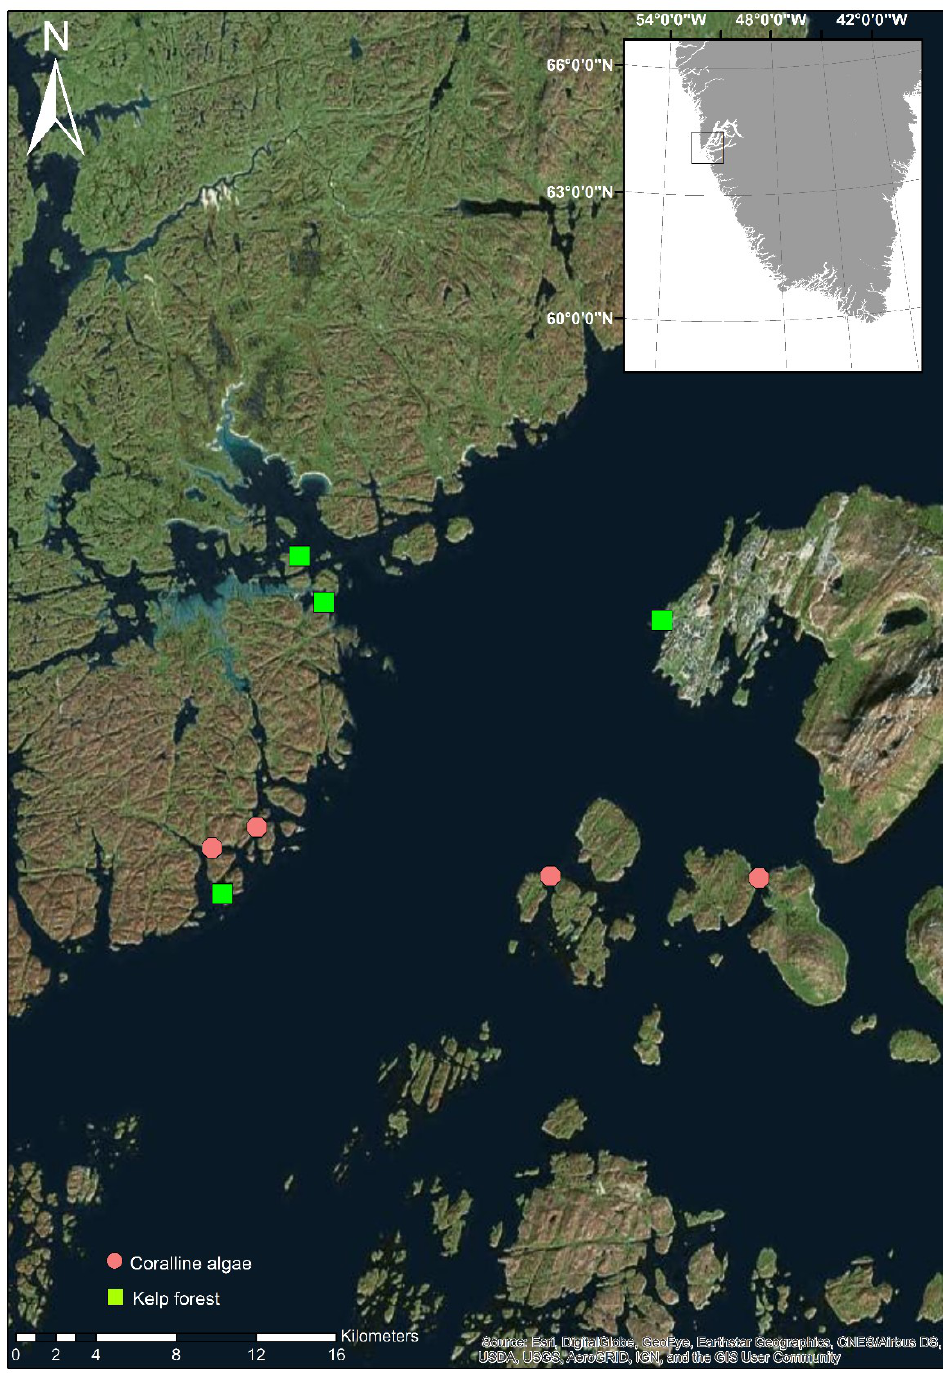
Figure 1. Map of the research area (WGS 1984 Web Mercator Auxiliary Projection) around the Akia peninsula and the seaward islands near Nuuk, with an inset referencing the location within Greenland. Green squares indicate kelp forest habitats and pink circles indicate rhodolith habitats that were sampled.